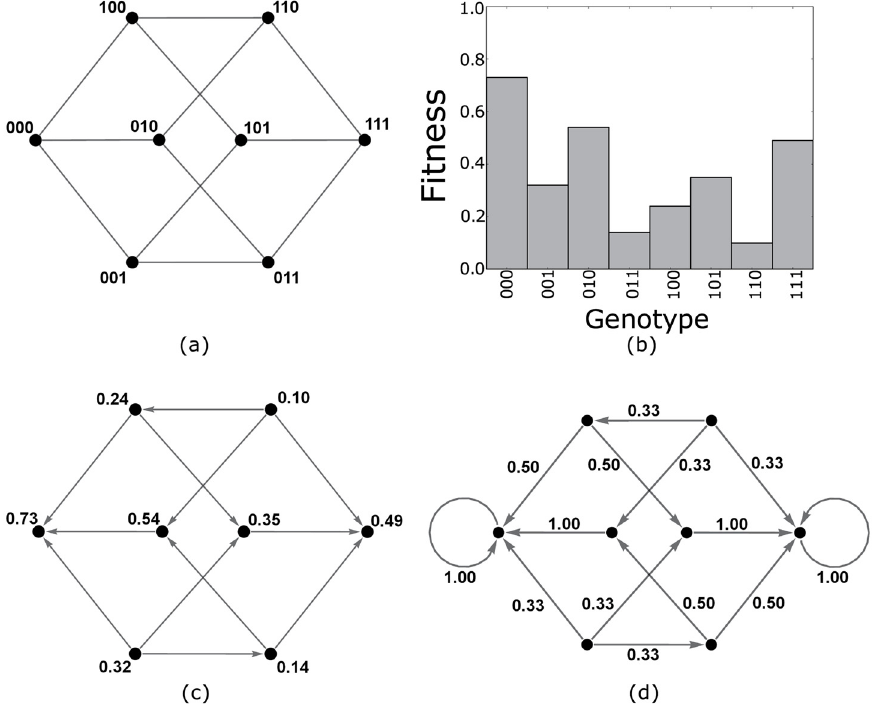
Fig 3. Constructing the Markov chain from a fitness landscape. (a) The space of genotypes comprising bit strings of length N = 3. The vertices represent genotypes, and edges connect those genotypes that are mutational neighbors. (b) An example fitness landscape. (c) The directed evolutionary graph according to the landscape in (b) where the vertices represent genotypes and are labeled by the associated fitness. The directed graph edges are determined by the fitness function and represent those mutations which can fix in a population (those which confer a fitness increase). (d) The Markov chain constructed for the same landscape according to Eqs (2) and (3) with r =